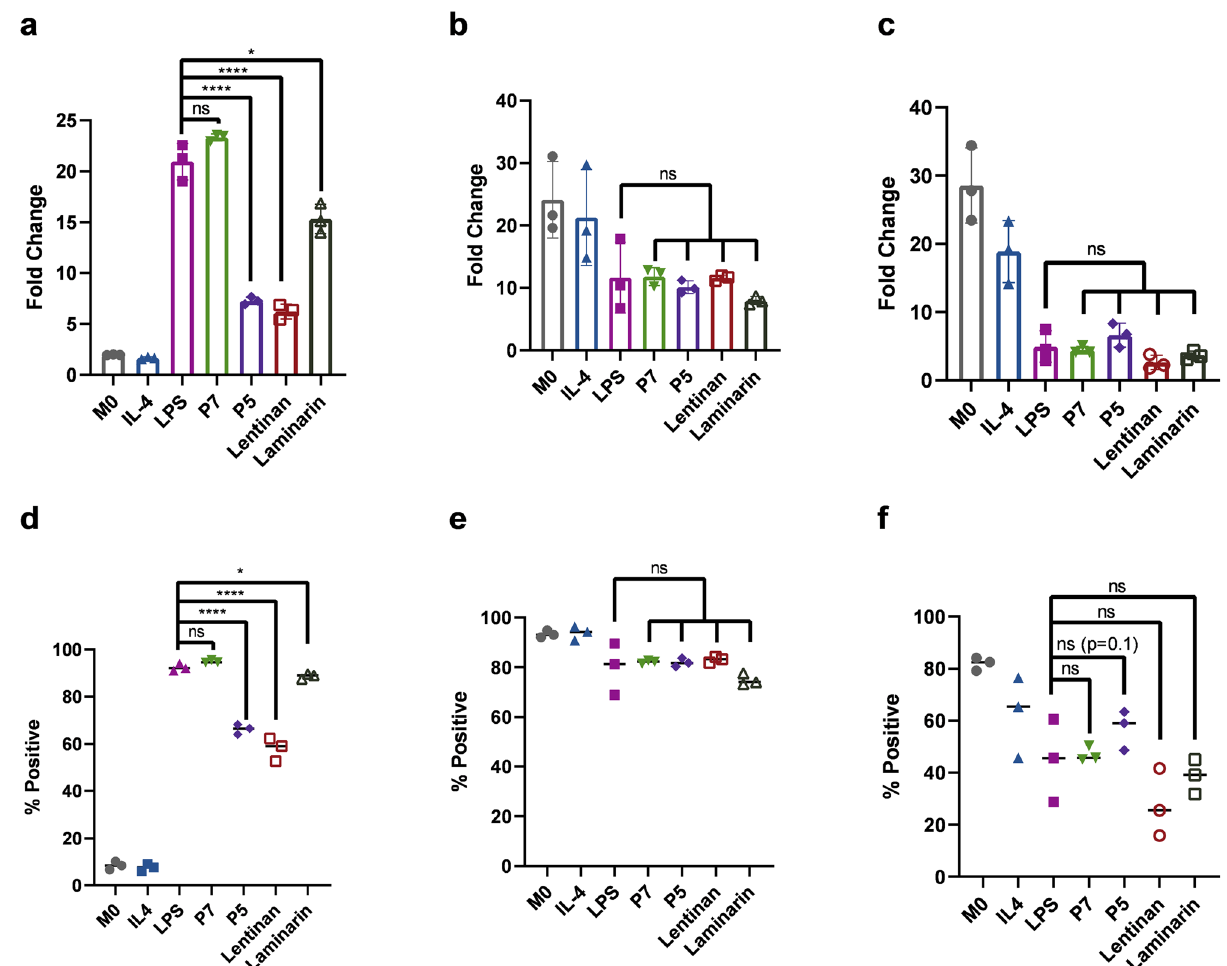
Fig. 7 | Primary macrophage expression of M1 and M2 polarization markers evaluated by fl ow cytometry after treatment with medium only, IL-4, LPS, P7, P5, Lent, or Lam. Fold change of median fl uorescence intensity of a CD80, b CD206, and c CD163 compared to an unstained control. Two-tailed unpaired t testwereperformedfor a LPSvsP5( p =0.0002),LPSvsLentinan( p =0.0002),LPS vs Laminarin ( p =0.0132). Percentage of positive cells of d CD80, e CD206, and